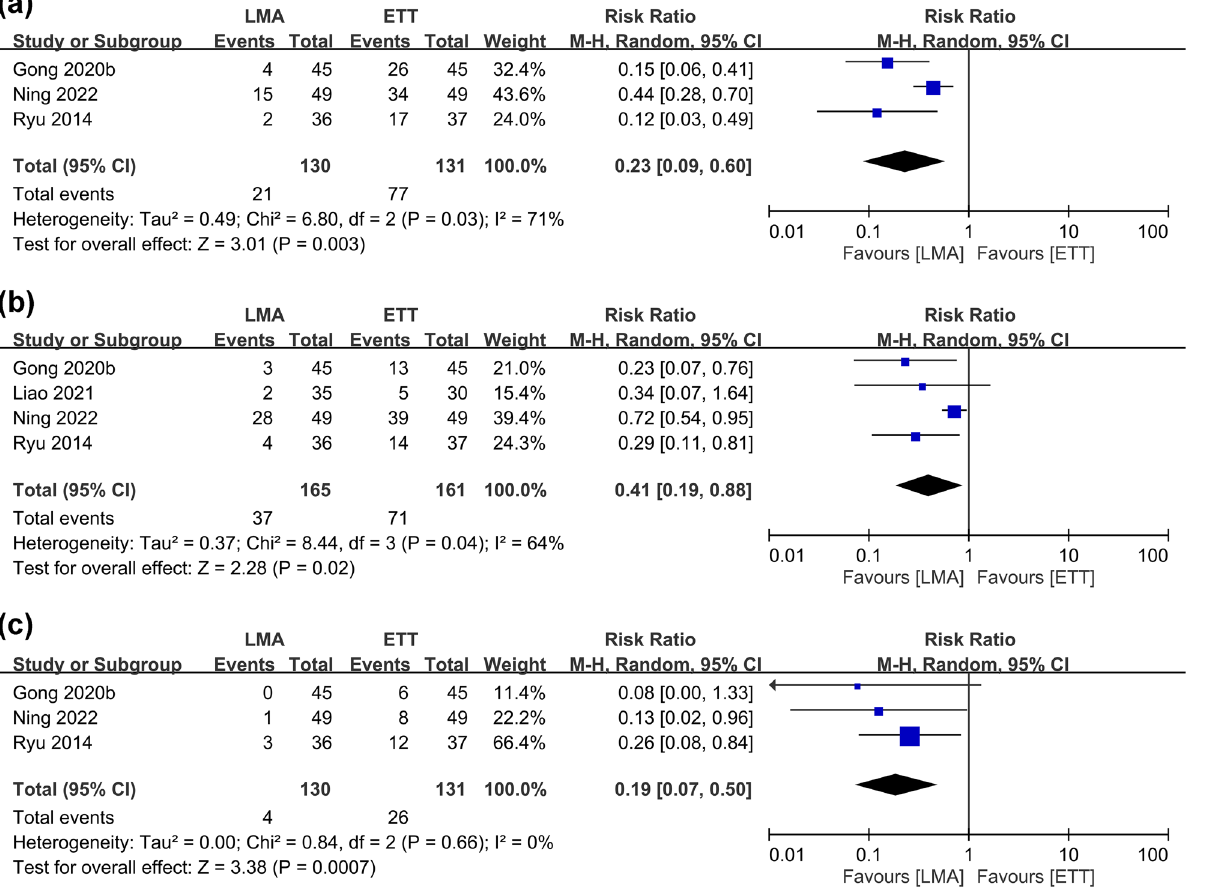
Figure 5. Forest plot comparing the risk of postoperative hoarseness at ( a ) 1 h, ( b ) 24 h, and ( c ) 48 h between laryngeal mask airway (LMA) and endotracheal tube (ETT) groups. CI confidence interval, M–H Mantel–